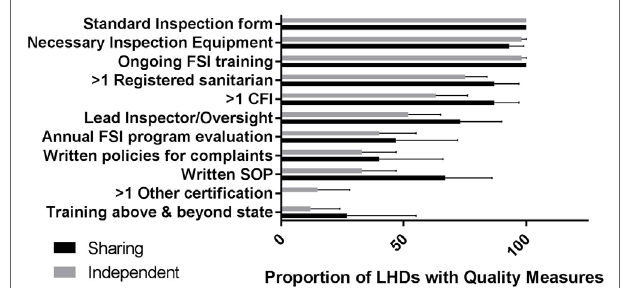
Table 7 ). Seventy percent of independent departments in